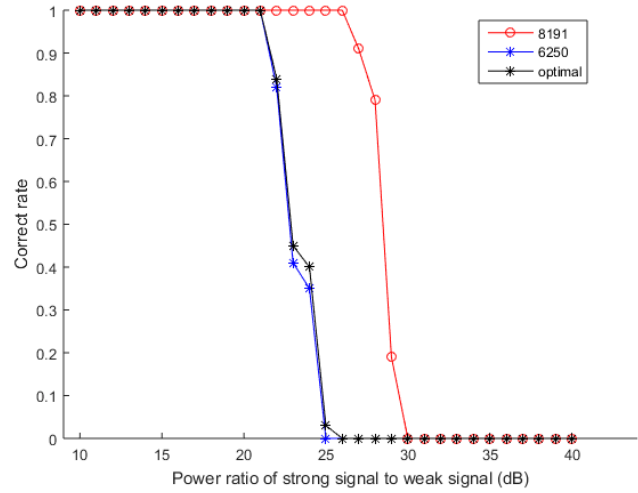
Figure 11. Contrast of Correct Rate of Complete Gold Code and Truncated Gold Code.